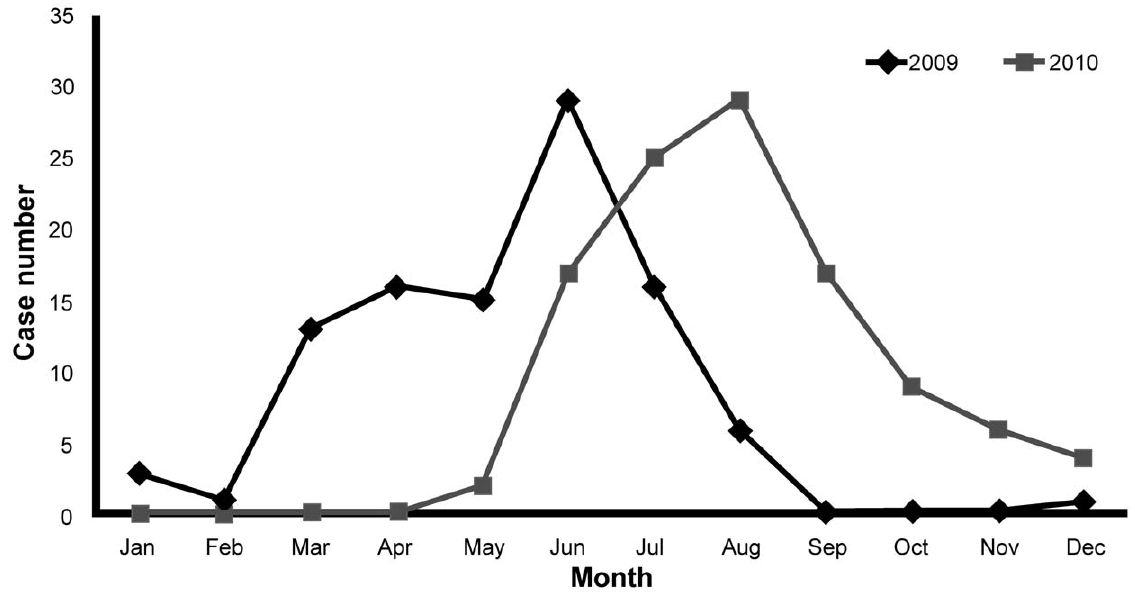
Figure 3. Alignment of the nucleotide sequences of 3 9 UTR of CVA6. The first three strains (Accession Nos. JQ946050–JQ946052) were isolated from HFMD patients with small skin rush in 2009, but other three strains (Accession Nos. JQ946053–JQ946053) were isolated from HFMD patients with onchomadesis in 2010. The ‘-‘ denotes a gap and the ‘.’ denotes sequence identity in the sequence. Numbering is based on coxsackievirus A6 strain Gdula (accession No. AY421764).